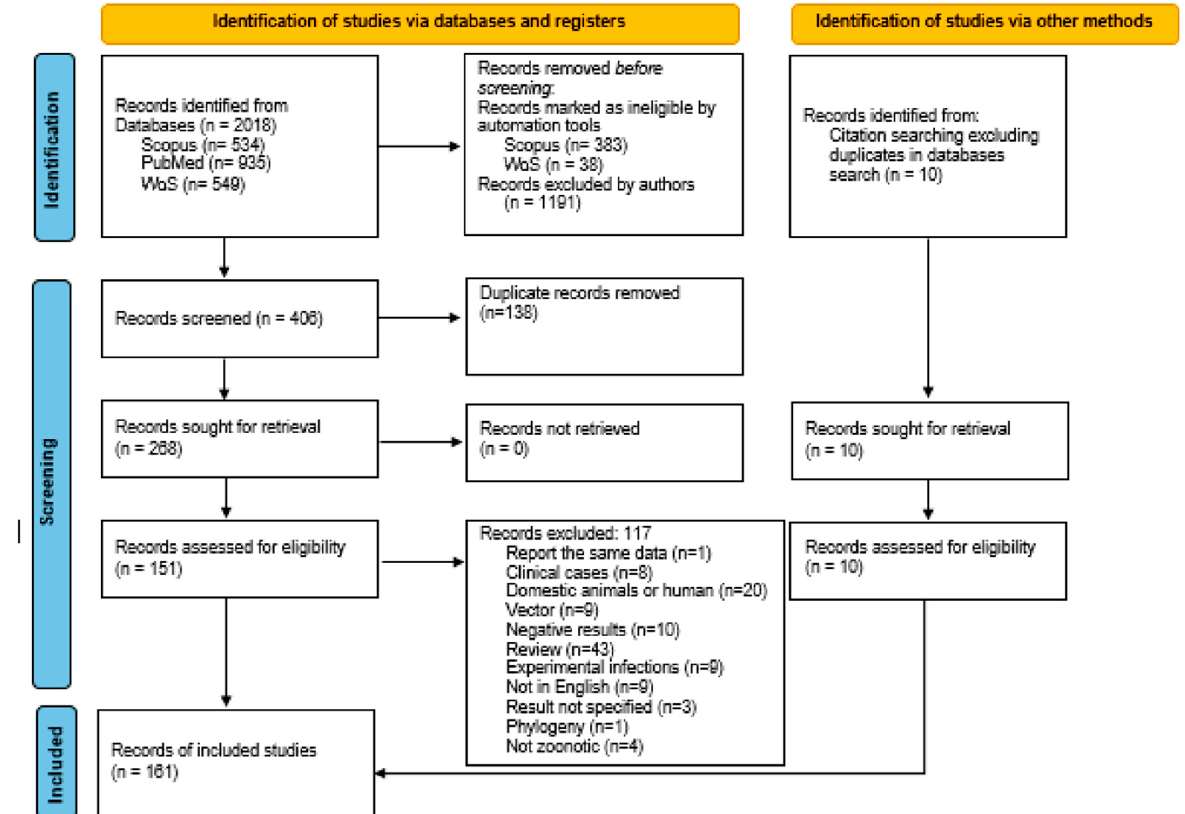
Figure 2. PRISMA 2020 flow diagram for the present systematic review.